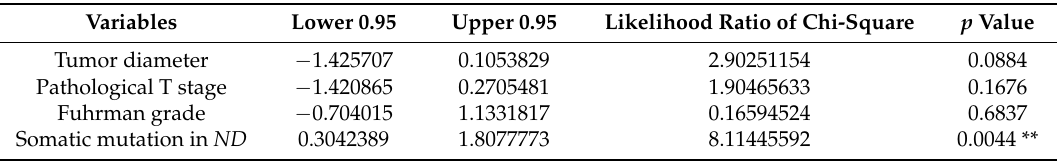
Table 4. Multivariate Cox proportional hazards regression analysis for factors associated with postoperative recurrence of localized RCC.